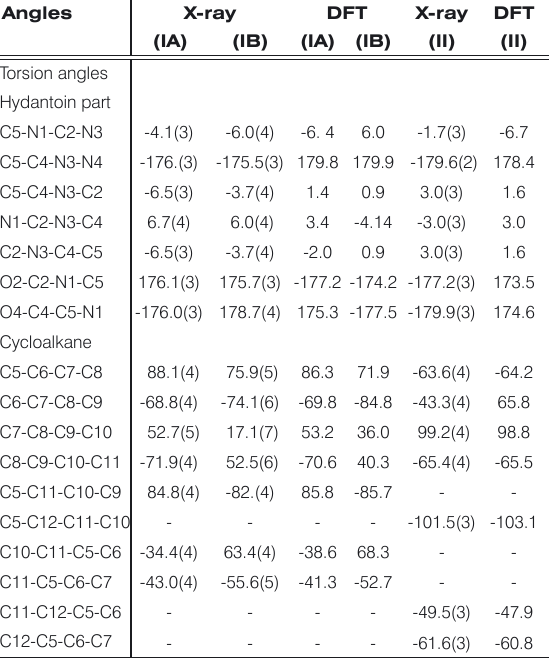
Table 2. Selected geometrical parameters for X-ray structures and DFT models. Angles